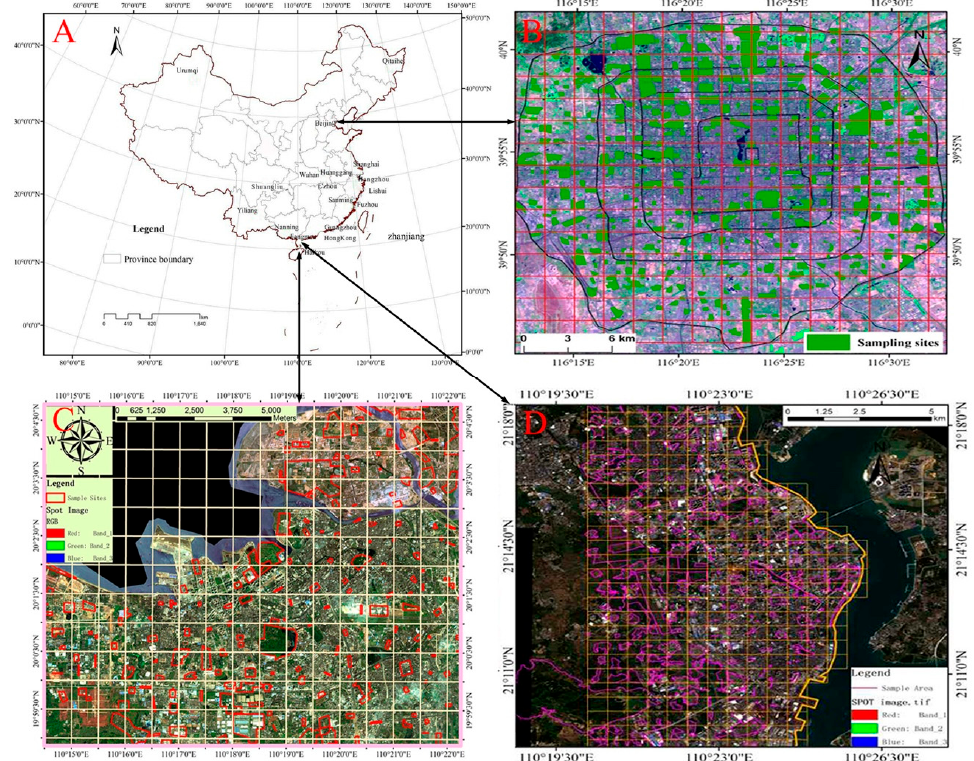
Figure 1. Satellite images showing the locations of the study sites ( A ) as well as the sampling